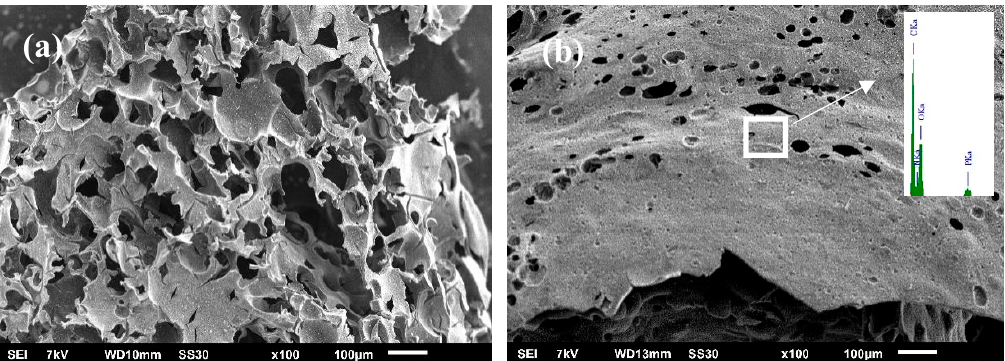
Figure 10. Char residue SEM image of PET ( a ) and SiMP-CMSs/PET composites ( b ).